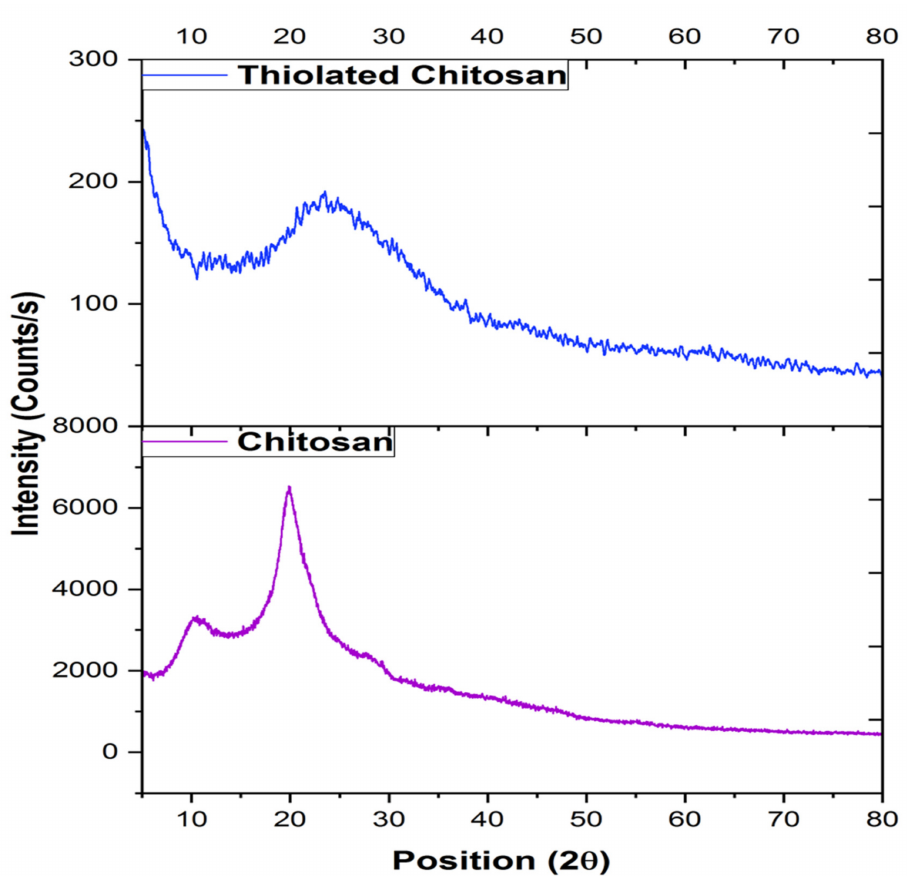
Figure 5. X-ray Diffraction spectra of chitosan and thiolated chitosan synthesized by covalent bond formation between thioglycolic acid and chitosan via EDAC